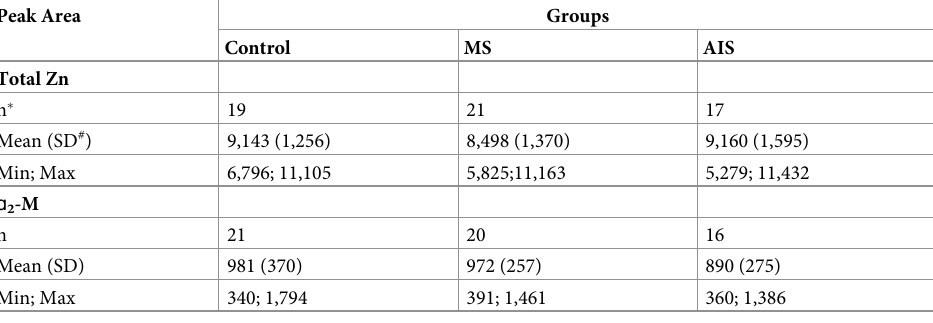
� number of individuals per group. # standard